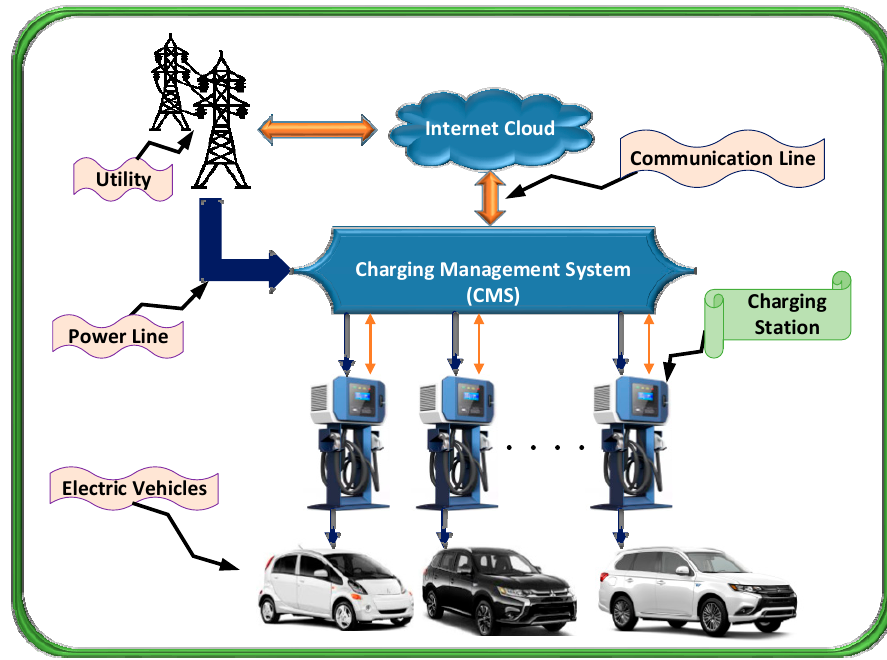
Figure 1. Charging Management System (CMS).